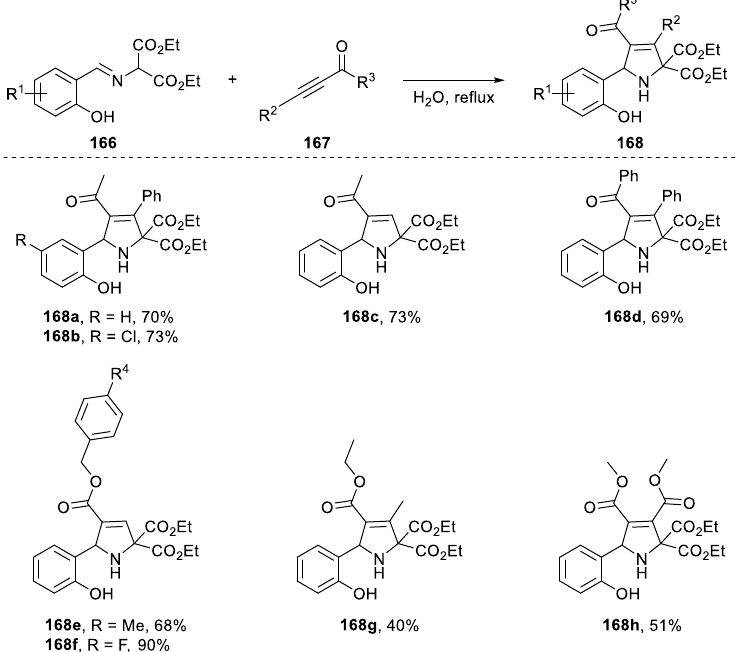
Molecules 2023 , 28 , x FOR PEER